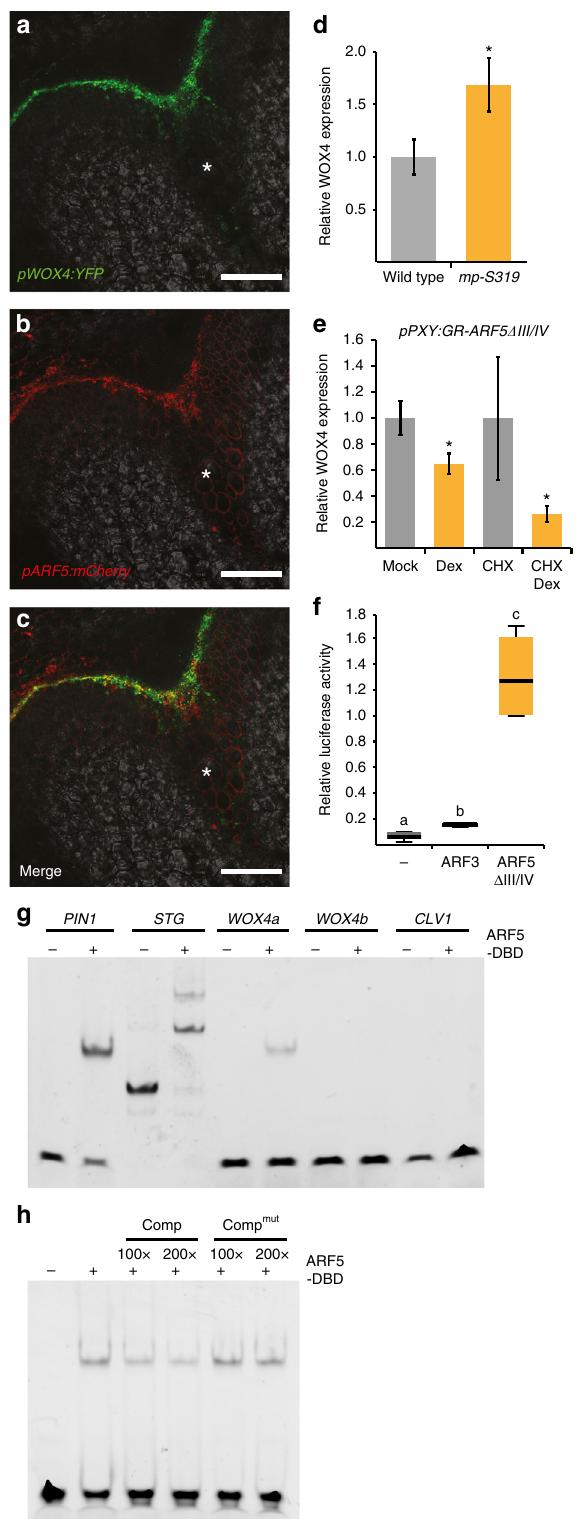
as a negative control. Oligomer sequences are shown in Supplementary Table 1. h EMSAs probing the WOX4a oligomer in the presence of the non- labelled WOX4a competitor (comp) (in 100× and 200× excess) and in the presence of a mutated WOX4a oligomer (comp mut ) (with 100× and 200×